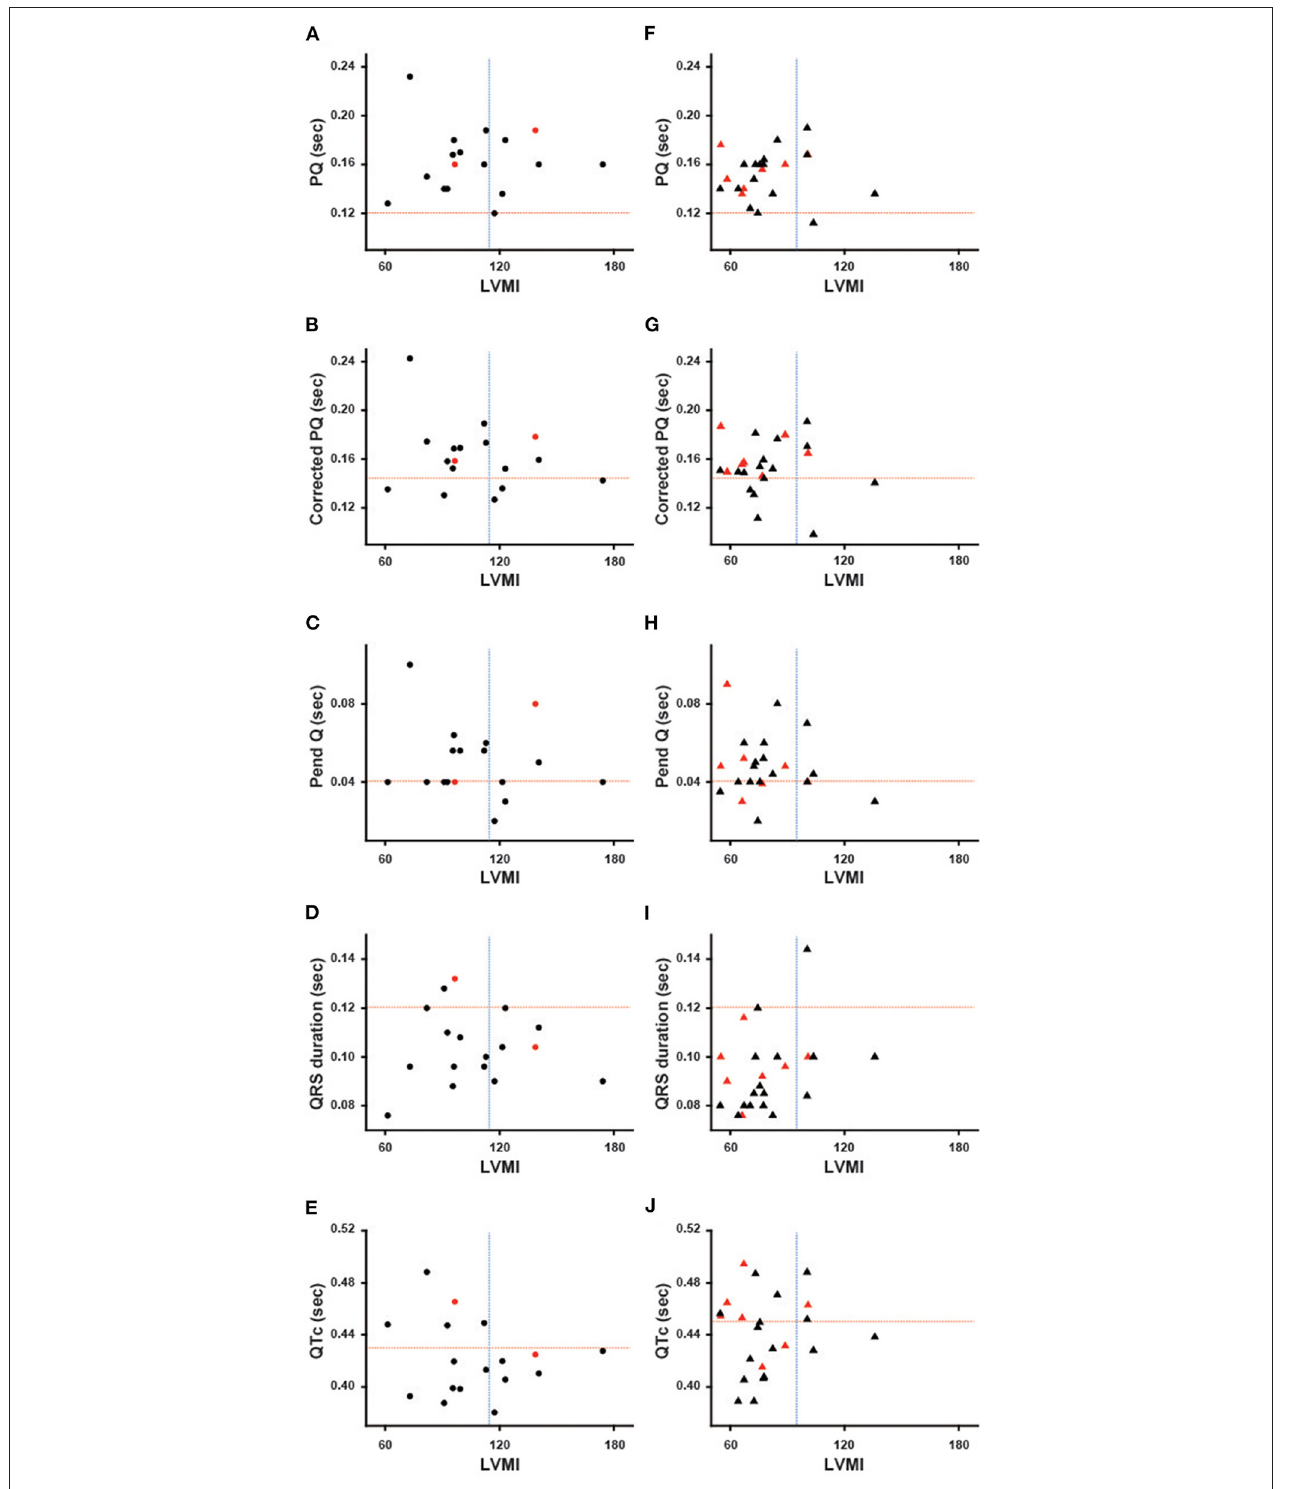
FIGURE 1 | Various ECG parameters plotted against the left ventricular mass index of each patient. The left columns show the parameters of male patients (A–E) , and the right columns show the parameters of female patients (F–J) . Black symbols show the patients with the classical type, and red symbols show the patients with the late-onset type. The horizontal dotted lines indicate the cut-off value for the abnormalities in each parameter, and the vertical dotted lines indicate the cut-off value for the left ventricular hypertrophy. Corrected PQ, PQ interval divided by the square root of RR interval; Pend-Q, PQ interval minus P-wave duration in lead II; QTc, QT interval divided by the square root of RR interval; LVMI, left ventricular mass